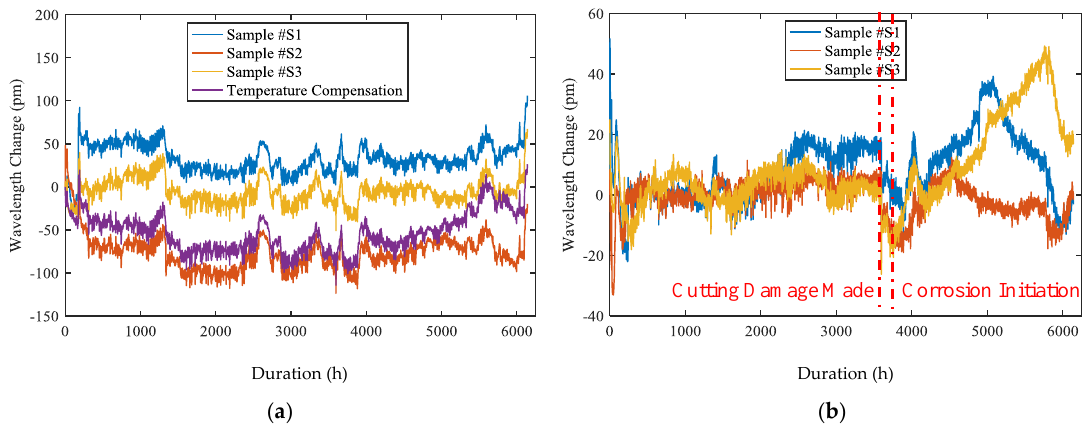
Figure 6. Bragg wavelength of embedded FBG sensors with soft coating vs. time ( a ) before temperature compensation and ( b ) after temperature compensation.